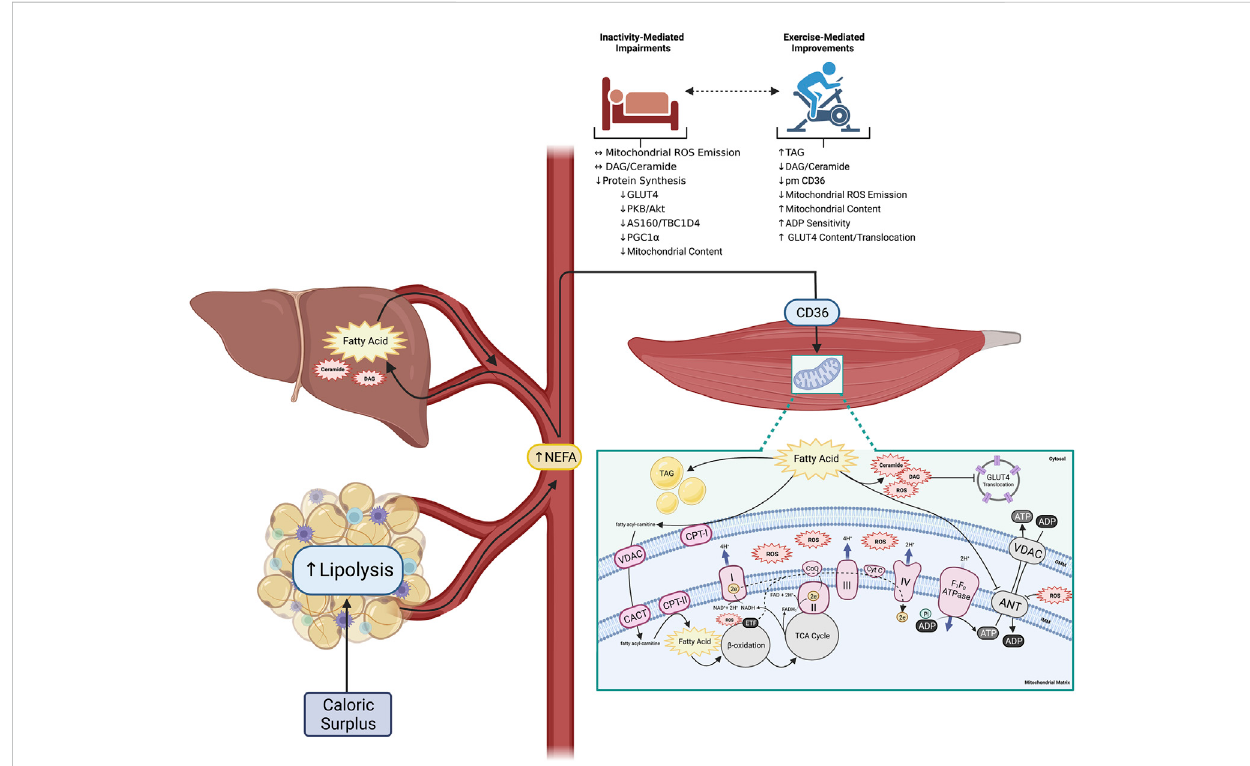
FIGURE 1 Altered peripheral tissue lipid metabolism initiates skeletal muscle reactive lipid accretion and ROS emission, a mechanism linked to peripheral insulin resistance. Obesity is associated with increased lipid availability (from both an impaired ability to regulate adipose tissue lipolysis, and increased hepatic denovo lipogenesis)resultinginincreased fl uxoffattyacidsthroughplasmamembraneCD36inskeletalmuscleandtheaccumulationofvarious fatty acid species. While some excess fatty acids are converted to TAG for neutral storage, others support the accumulation of reactive lipids (DAG and ceramide). Accumulation of reactive lipids potentiate mitochondrial ROS emission due to increased CPT-I dependent fatty acid transport into the mitochondria, which directly attenuates ADP transport at the level of ANT. Importantly physical inactivity can exacerbate the induction of peripheral insulin resistance, while physical activity can mediate many of the outlined perturbations (created with BioRender.com). Abbreviations: Adenine nucleotide translocase (ANT), adenosine diphosphate (ADP), adenosine triphosphate (ATP), carnitineacylcarnitine translocase (CACT), carnitine palmitoyltransferase-I,-II(CPT-I,-II),cytochromeC(CytC),diacylglycerol(DAG),electron(e − ),electrontransportchaincomplexesI — IV(I — IV),electron transfer fl avoprotein (ETF), fatty acid translocase (CD36), fl avin adenine dinucleotide (FADH2), glucose transporter 4 (GLUT4), inner